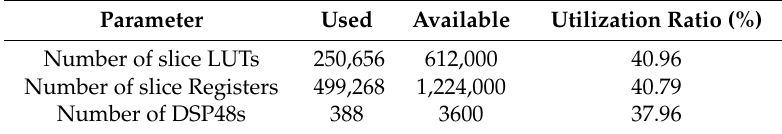
Table 7. The logic unit utilization ratio of the coordinate transformation method.